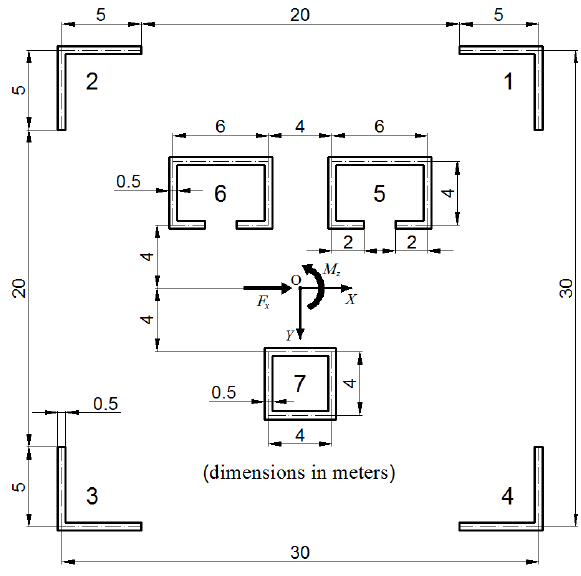
Figure 9: Floor plan of the